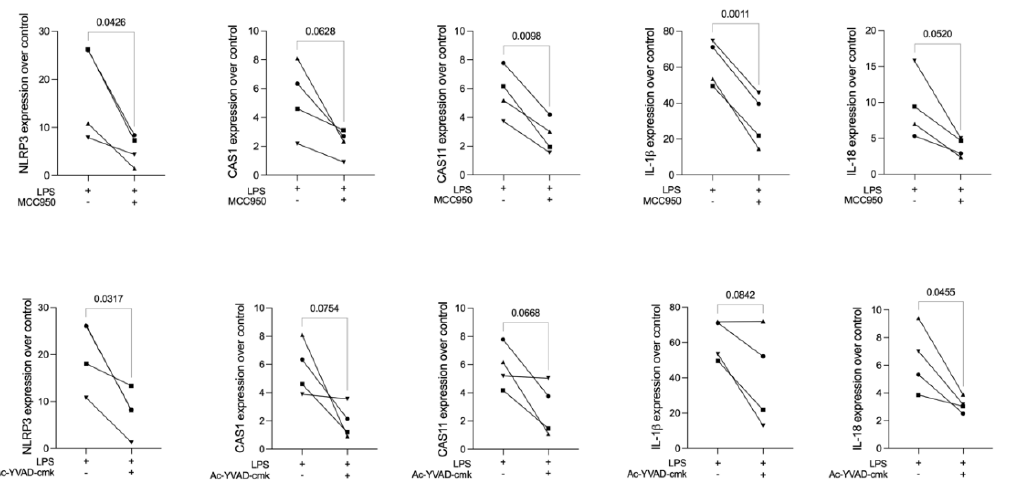
Figure 1. LPS stimulation caused an increase in the expression of the pyroptosis genes NLRP3, CAS1, CAS11, IL-1 β , and IL-18 in primary macrophages. The application of MCC950 prior to LPS stimulation in primary macrophages led to a significant reduction in the expression of NLRP3, CAS11, and IL-1 β , and a trend in the reduction of CAS1 and IL-18. The application of Ac-YVAD- cmk prior to LPS stimulation in primary macrophages led to a significant reduction in the forced expression of NLRP3 and IL-18, and a trend in the reduction of CAS1, CAS11, and IL-1 β . Different symbol shapes mean independent experiments. Paired t-test statistical analysis was applied to com- pare the groups.